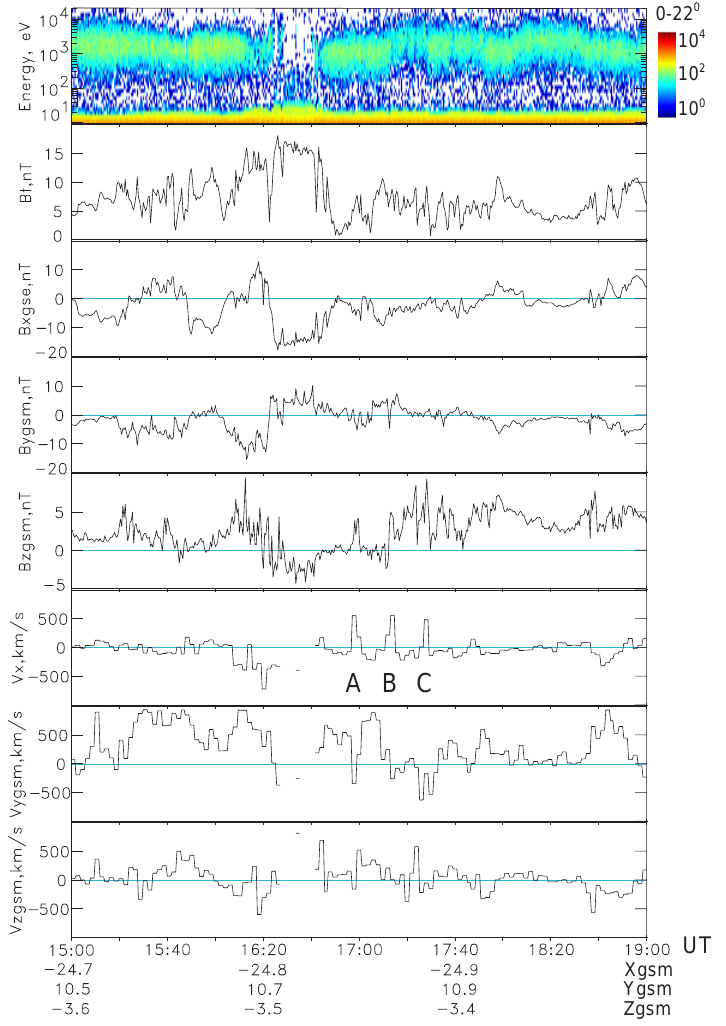
Fig. 2. Interball-1 data for the time interval 15:00–19:00UT. From top to bottom: energy-time spectrogram of the tailward directed electrons (energy fluxes are color-coded), magnetic field magnitude, magnetic field and plasma velocity components in the GSM sys- tem. Labels A, B, and C indicate bursty bulk flow (BBF) events discussed in the